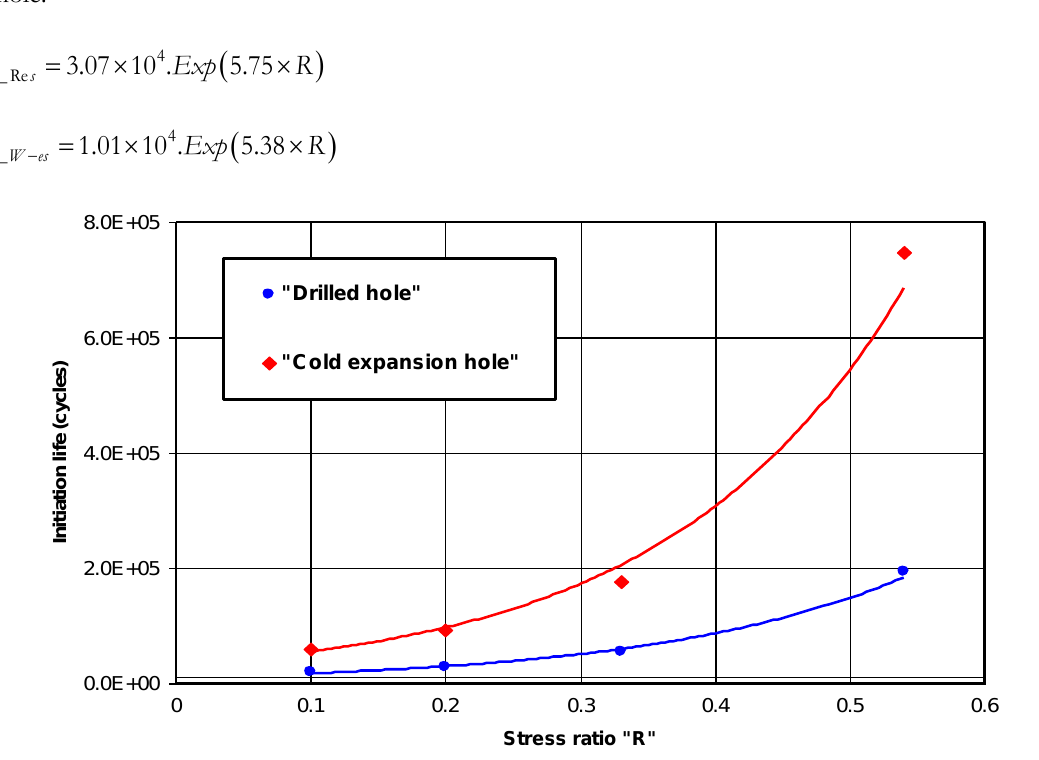
Figure 8: Effect of cold expansion of hole on initiation fatigue